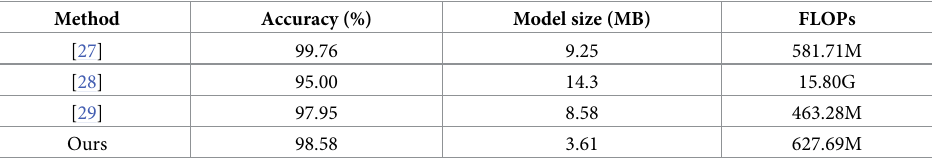
Table 4. Comparison of model performance results with other